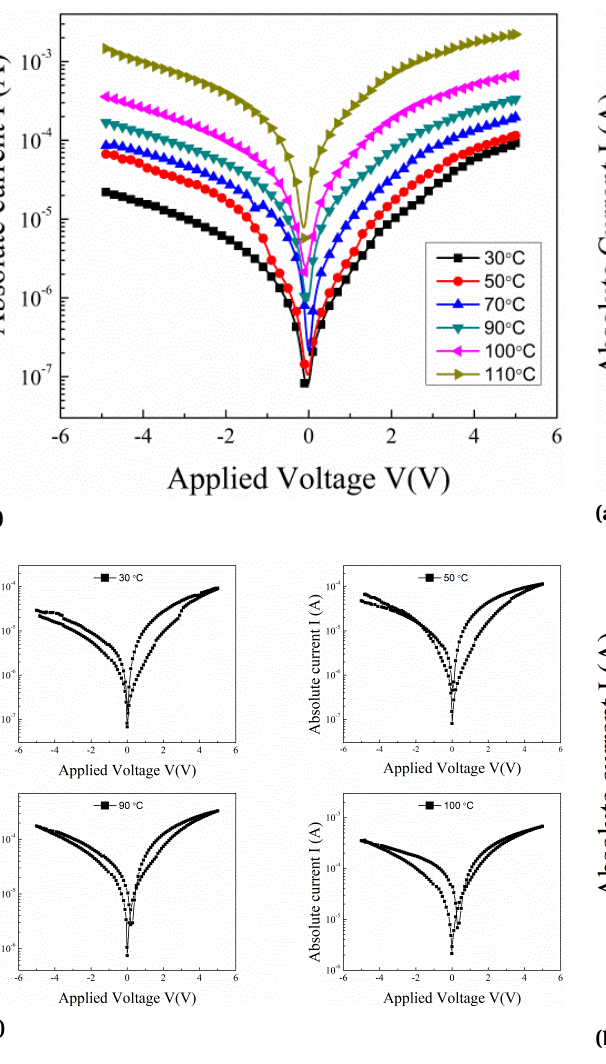
Figure 3: I-V characteristics for PVA/PANi/5 wt.% Fe 3 O 4 blend